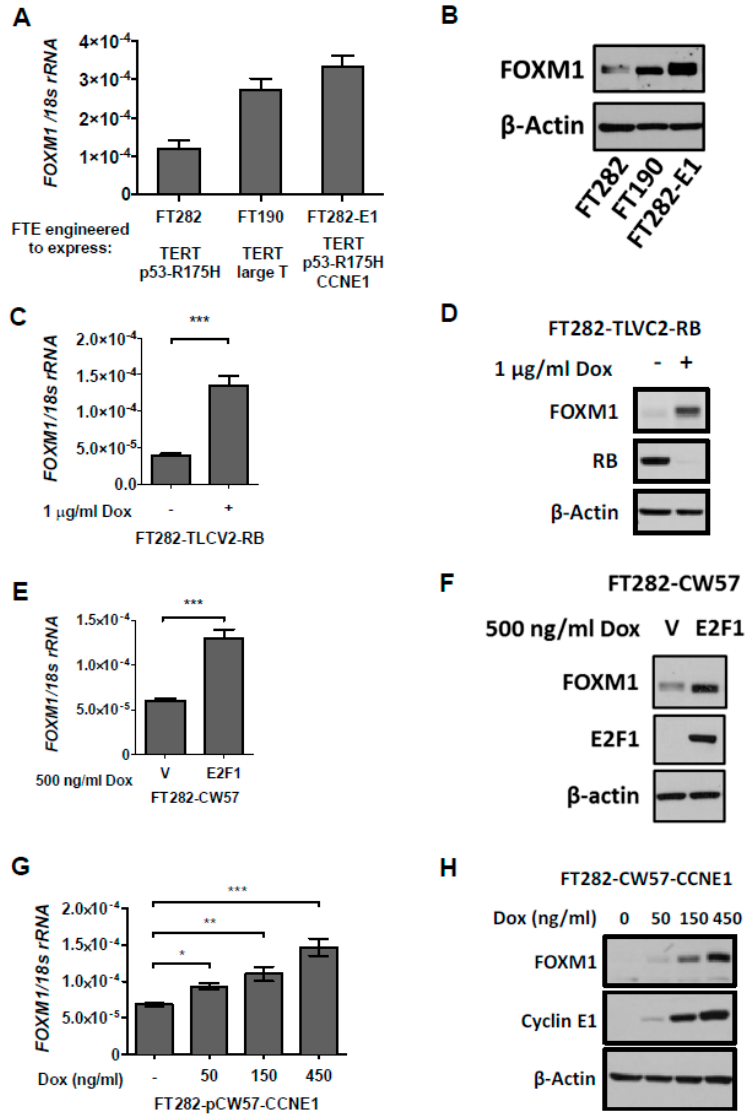
Figure 6. FOXM1 expression in fallopian tube epithelial (FTE) cells engineered for deregulation of the Rb-E2F pathway. ( A , B ) FOXM1 mRNA and protein expression were measured by RT-qPCR and Western blot, respectively, in the indicated FTE cell lines. β -actin is shown as a loading control. ( C , D ) FOXM1 expression by RT-qPCR and Western blot, respectively, in RB1 CRISPR KO FT282 cells. ( E , F ) FOXM1 expression by RT-qPCR and Western blot, respectively, in E2F1 inducible FTE cells. ( G , H ) FOXM1 expression by RT-qPCR and Western blot, respectively, in CCNE1 inducible FTE cells. Bars represent mean ± SD. Student’s t test p values are shown. p value designations: *** < 0.001, ** < 0.01, * <